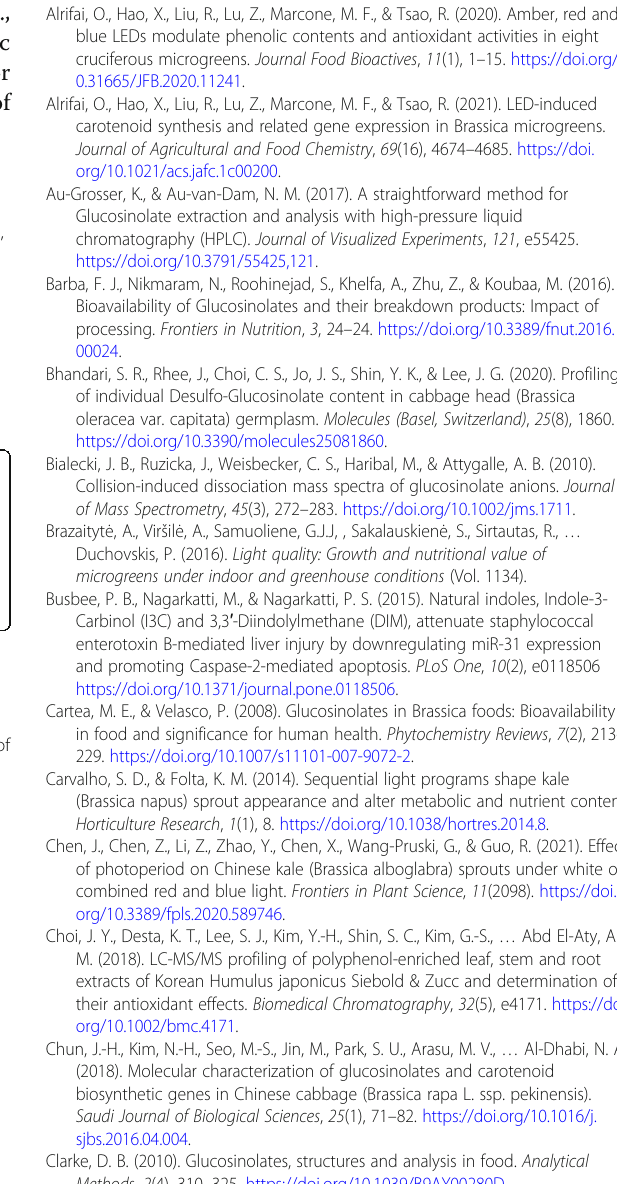
Additional file 2: Supplementary Table S2 . Limit of detection (LOD) and limit of quantitation (LOQ) of three standards of glucosinolates (sinigrin, glucobrassicin and gluconasturtiin) in each set of microgreens measured in μ